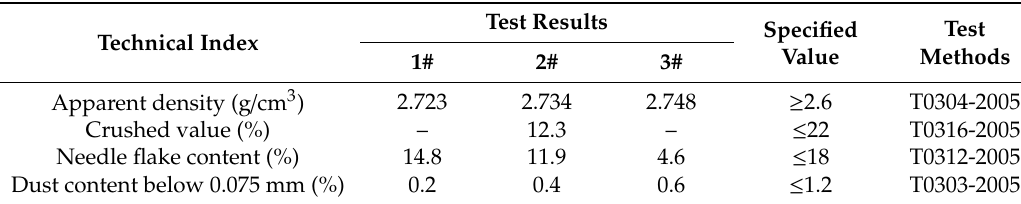
Table 2. Technical indexes of coarse aggregates.